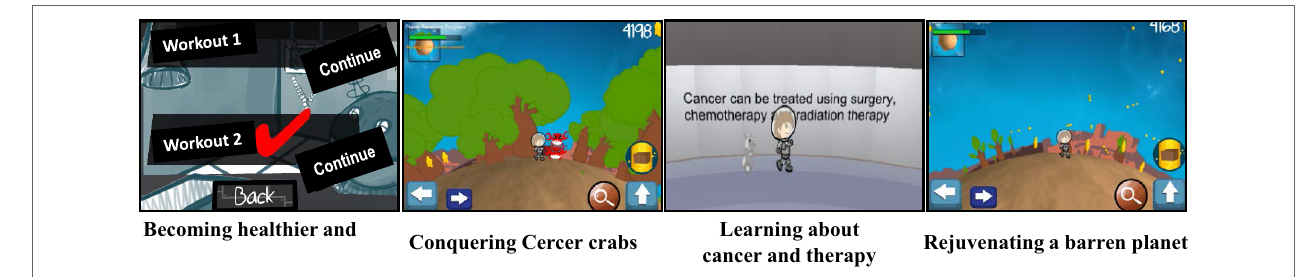
FigUre 5 | Physical, educational, and emotional empowerment themes are prominent throughout the prototype Empower Stars! video game . These themes include exercising to become stronger; conquering Cercer crabs that are metaphoric for cancer; learning about cancer, treatment and supportive care via educational messages and educational mini-games; and restoring life a barren planet by creating clouds, running water, plentiful trees, and new life form, a process summarized as “terraforming.”